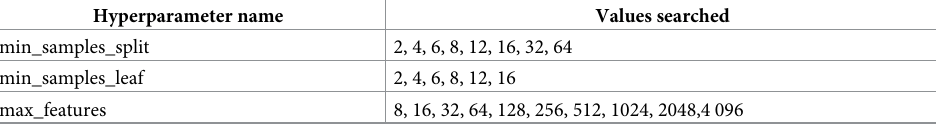
Table 3. Extents of the grid search for best hyperparameters of Random Forests Regressor models.